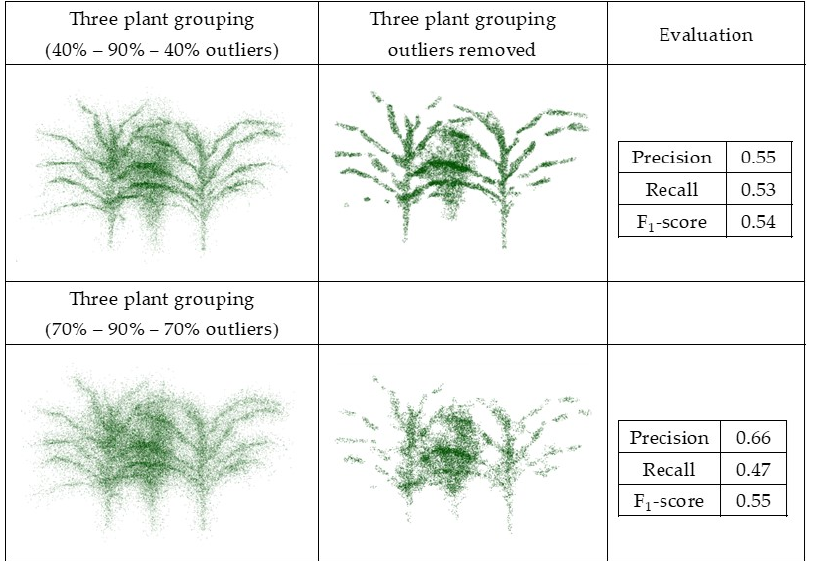
Figure 11. Geometric method outlier removal for a synthetic point cloud.